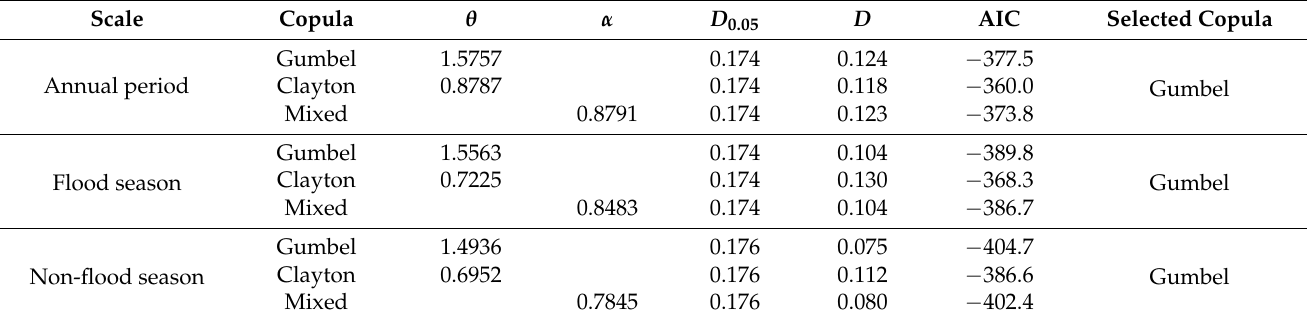
Table 12. The results of the parameter estimation, K-S tests, AIC values, and selected copula functions of the ternary copula functions among three